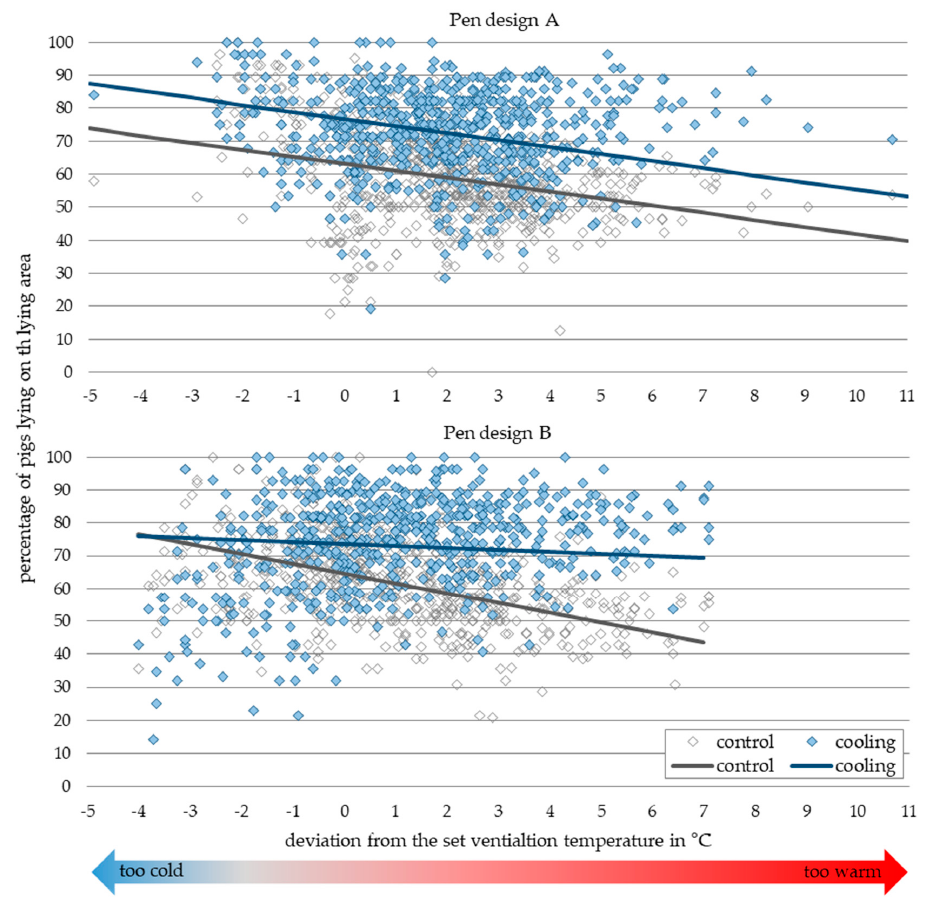
Figure 7. Effect of the deviation from the set ventilation temperature on the percentage of pigs (relative of the total number of lying pigs) lying on the solid lying area in pen design A and B. The diamonds show the raw data and the lines show the trend line.